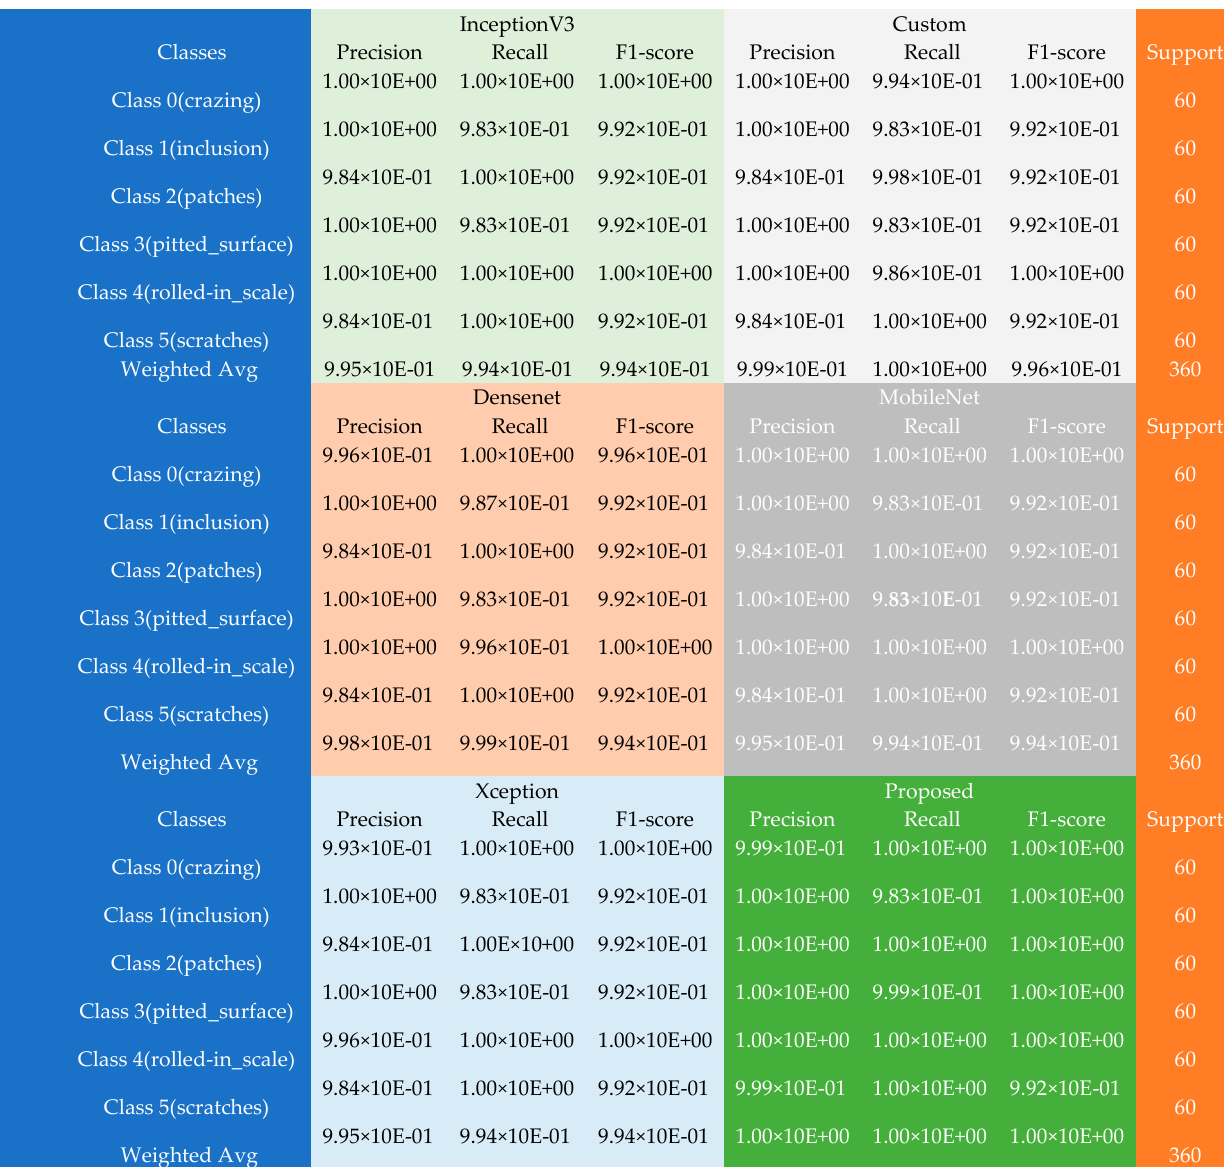
Figure 2. The confusion matrix table using the NEU dataset.